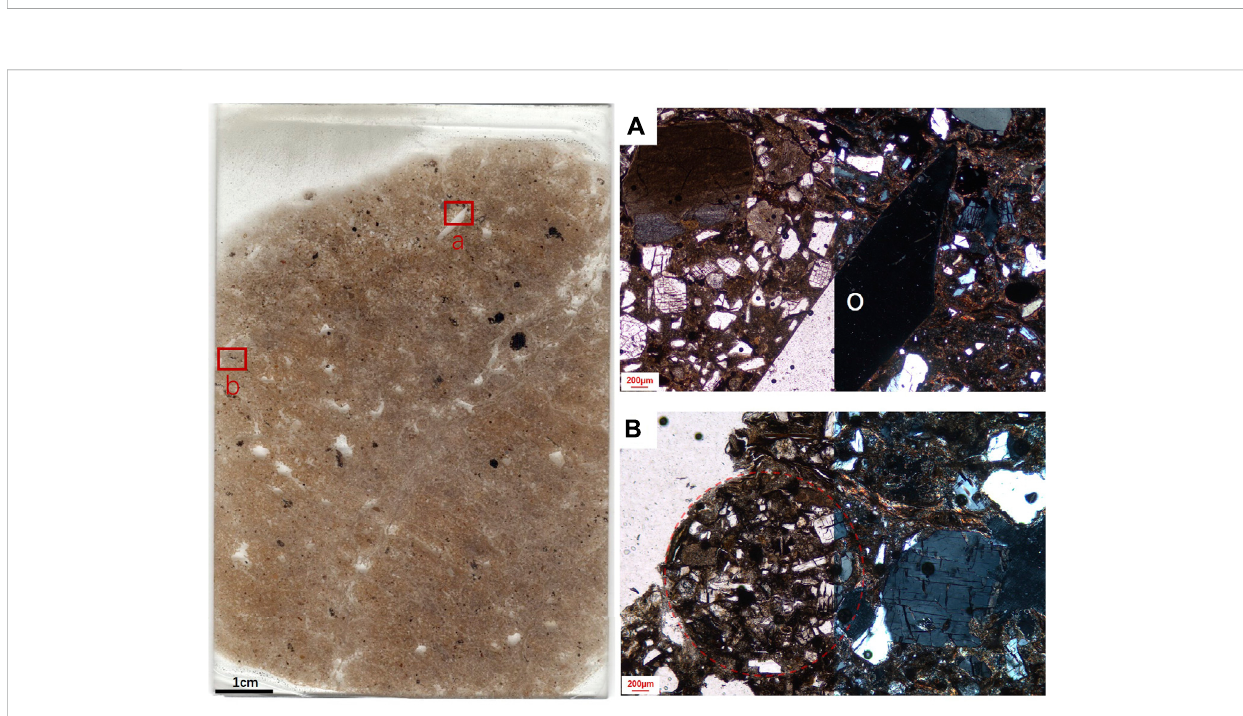
FIGURE 7 ScanofthethinsectionfromblocksampleDD9. (A) obsidianstoneartifact,verticallyaligned(PPLandXPL),O:obsidian; (B) granularaggregates(PPL and XPL), marked by red